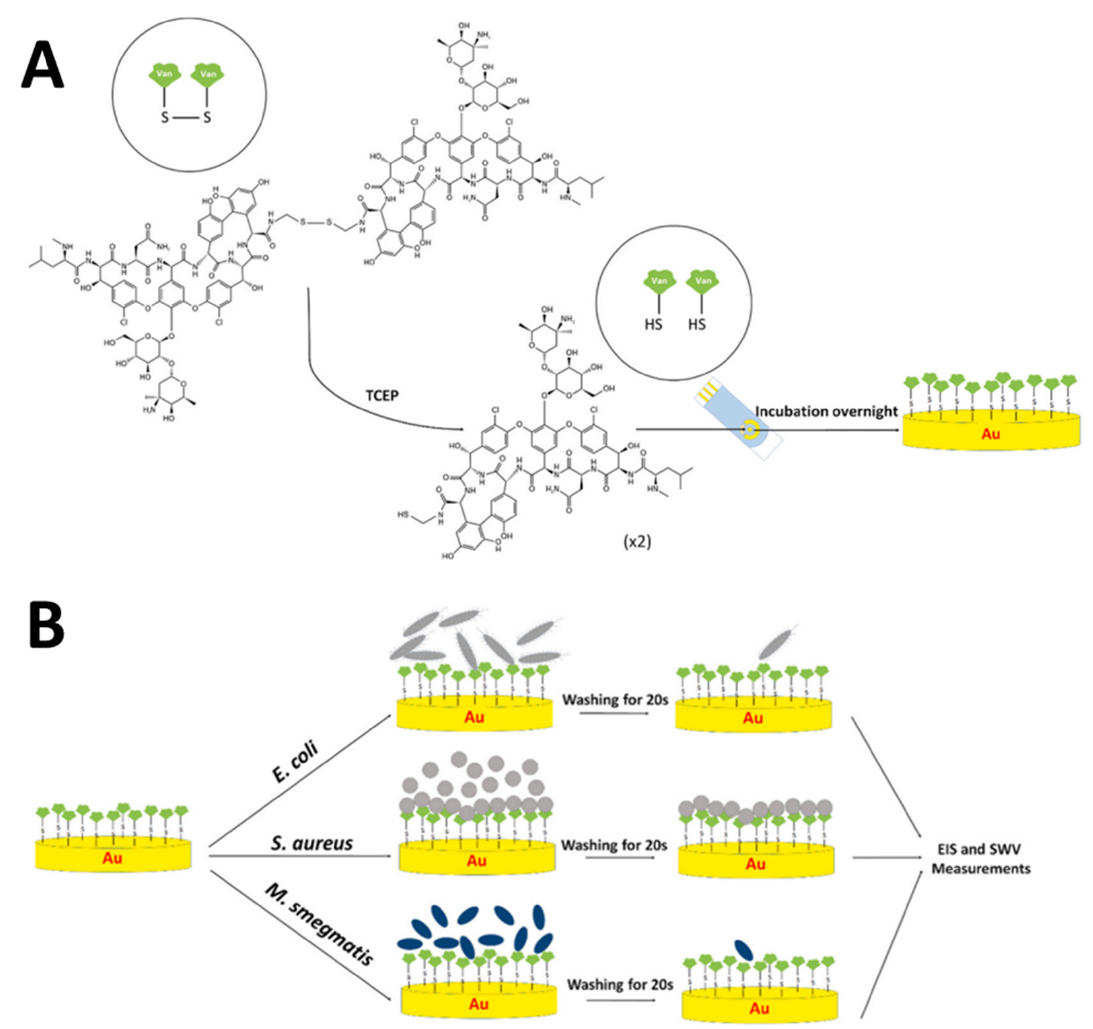
Figure 6. Schematic of Gram-positive bacteria detection based on a self-assembled monolayer (SAM) of vancomycin molecules on screen-printed gold electrodes. ( A ) Synthesis of Bis-vancomycin (Bis-Van) molecules with a disulfide bond and immobilization of Van molecules onto the SPGE surface via thiol chemistry. ( B ) Interaction of Gram-positive bacteria with Van-modified SPGEs. This figure has been retrieved from Dizaji and co-workers [44].